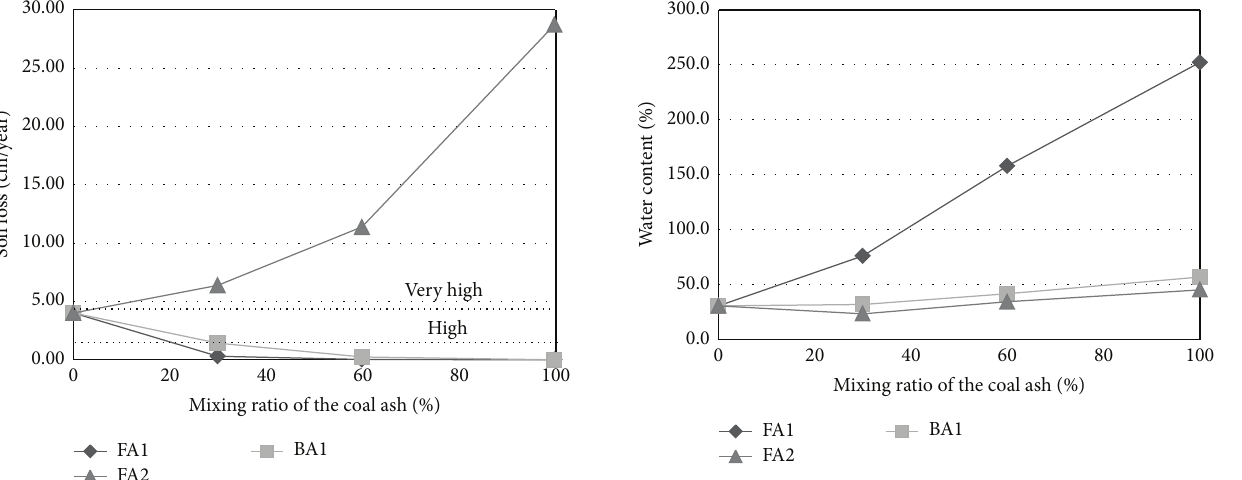
Figure8:Soillossofthesimulatedtopsoilmixedwiththecoalashat the mixing ratio of 0%, 30%, 60%, and 100% in the artificial rainfall test:arangeframedbydottedlinesindicateshighriskofsoilerosion.